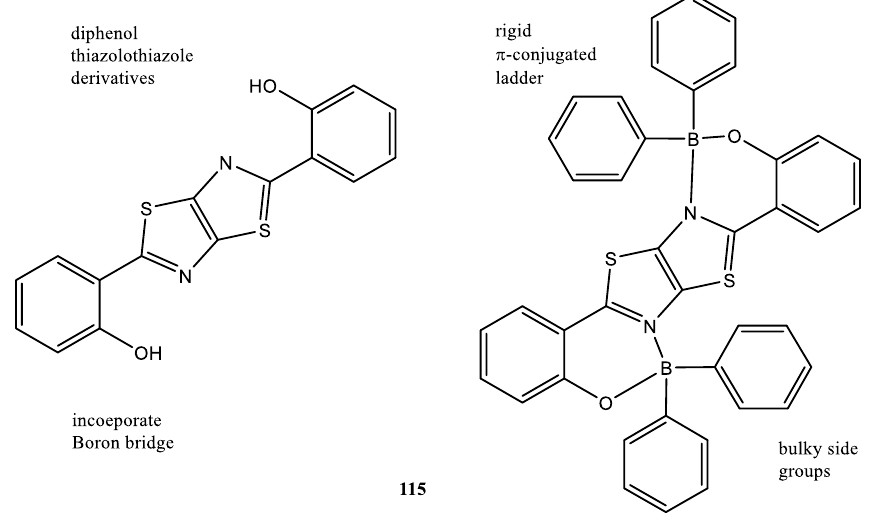
Figure 21. Design of a strategy toward a diboron-containing ladder 115 .